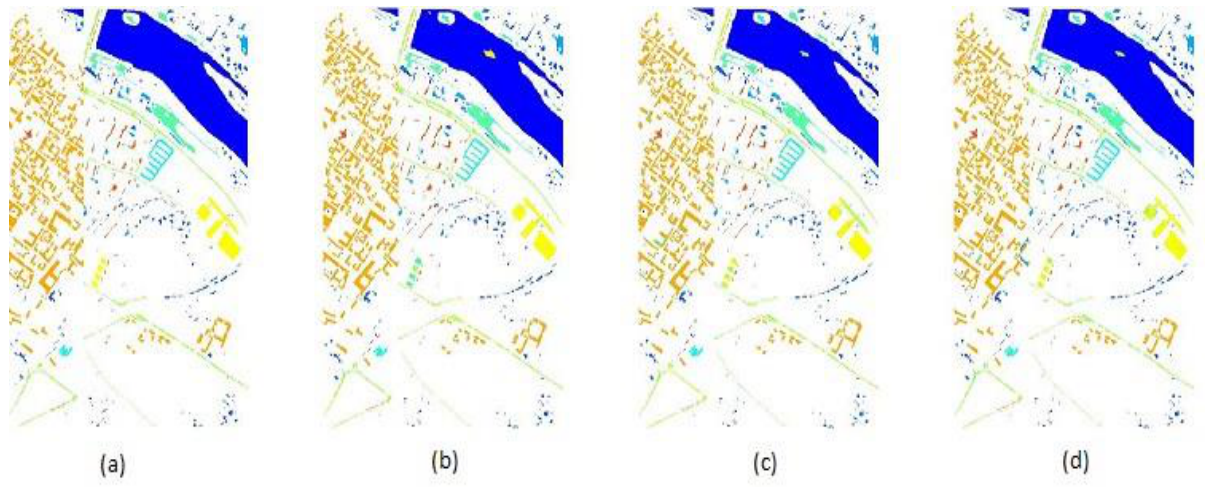
Figure 5. Classification map for the Pavia center dataset. (a) Reference map. (b) Spectral, (c) Spatial proposed method, (d)